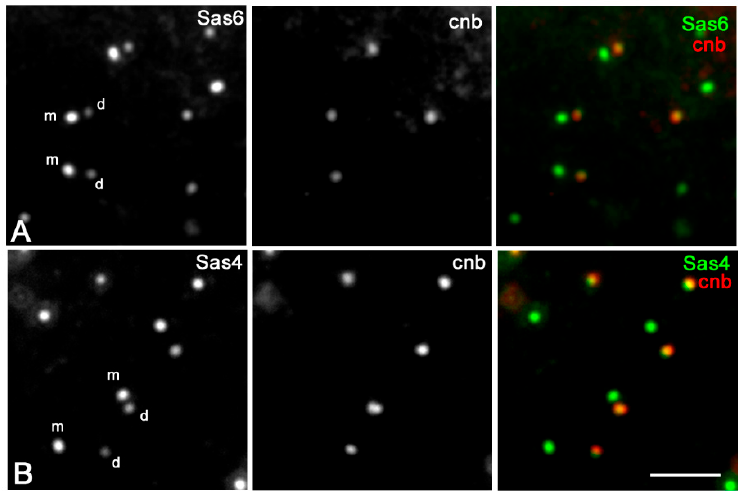
Figure 6. Sas6 and Sas4 loading in third larval imaginal wing cells. Double labeling with an anti-centrobin antibody (cnb, red) that specifically recognizes the daughter centrioles, shows that the immunofluorescence intensities of both Sas6-GFP (( A ), green) and Sas4 (( B ), green) at the mother centrioles are greater than the intensity to the daughter centrioles. m and d, are mother and daughter centrioles, respectively. Scale bar: 1 μ m.